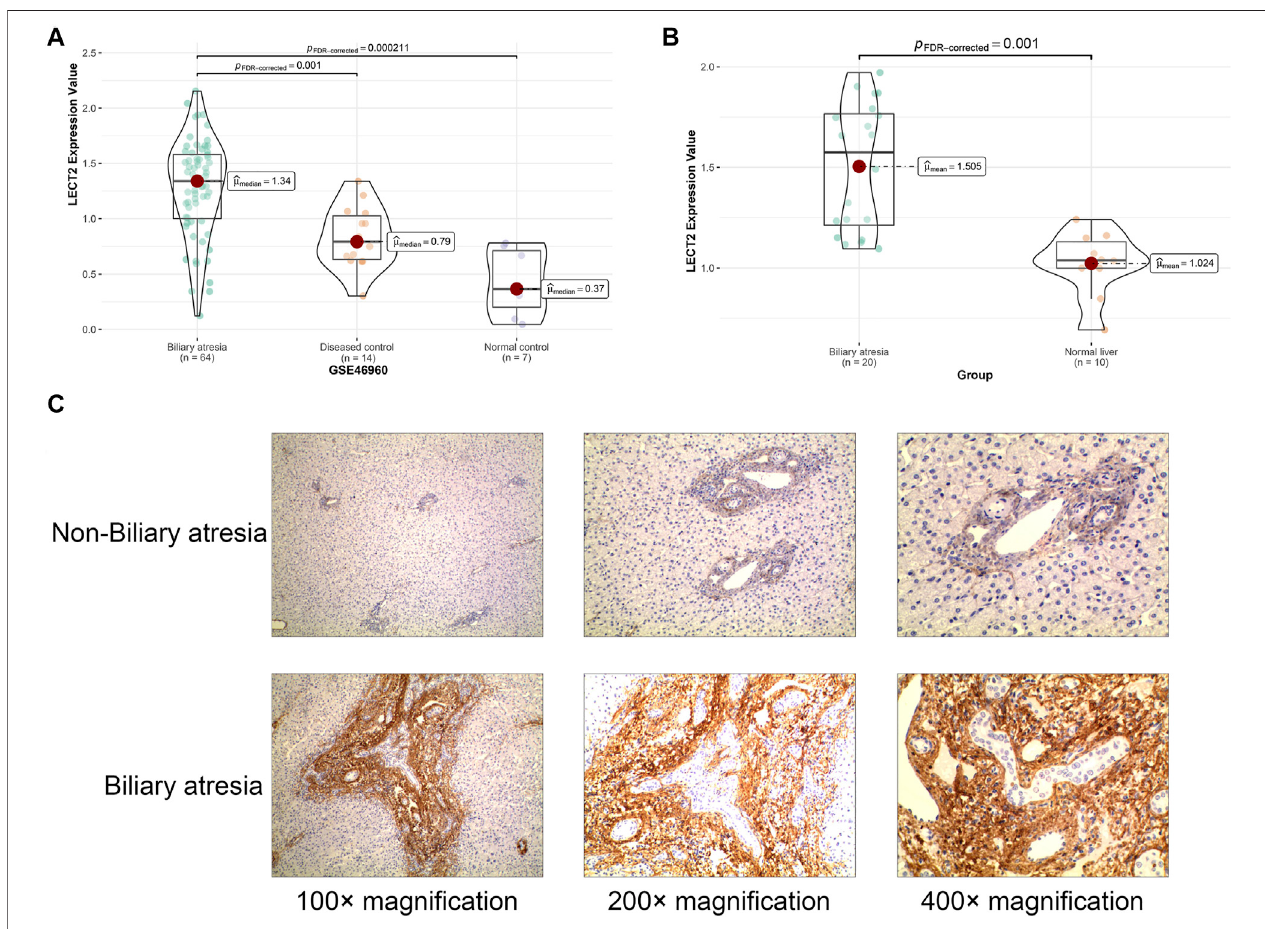
FIGURE3| Theexpression ofLECT2inbiliaryatresia (A) TherelativeexpressionofLECT2inGSE46960 (B) TherelativeexpressionofLECT2inclinicalspecimens (C) Immunohistochemistry for LECT2 in biliary atresia and non-biliary atresia groups.